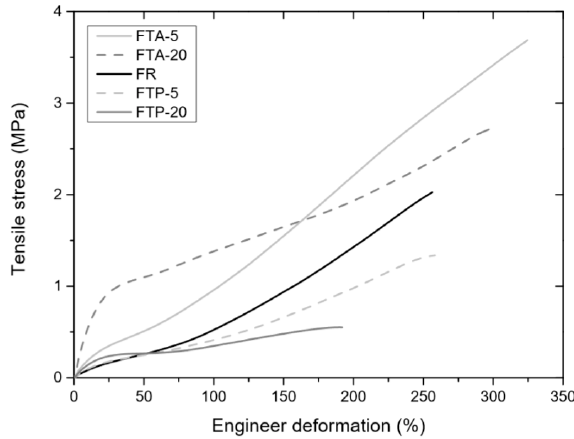
= 0.083%/s) at room temperature (Figure 10).